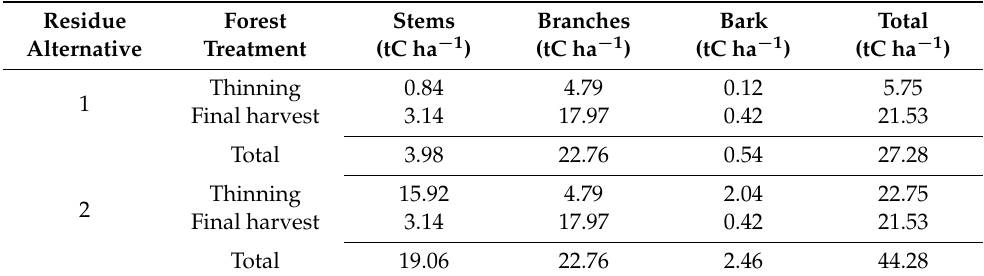
Table 3. Carbon in forest harvest residue for two residue utilization alternatives and forest treatments. Values are the total residues produced over the course of a single 30-year